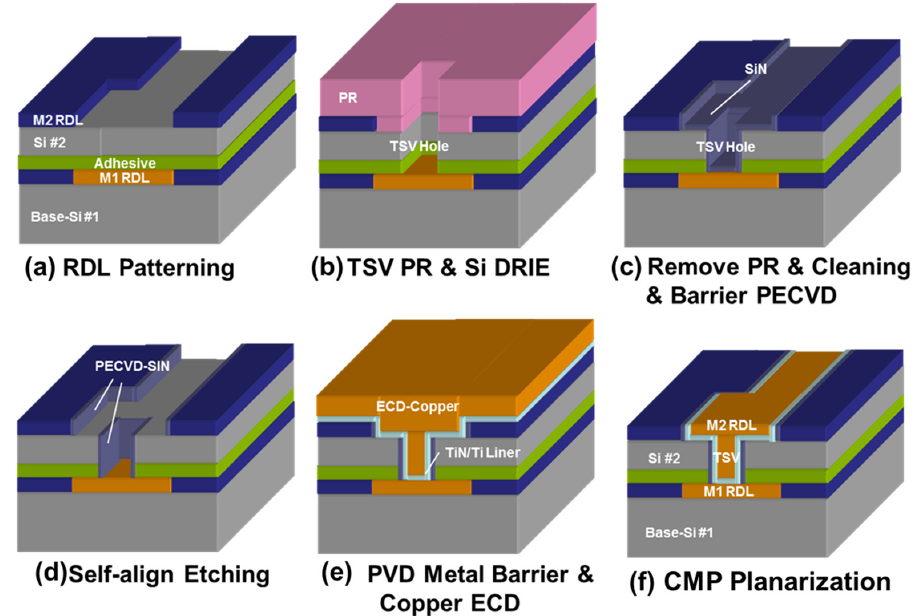
Figure 7. RDL formation and TSV (Cu plug) processes. After bonding of thinned wafer to another wafer surface, ( a ). RDL patterning, ( b ). TSV etching, ( c ). barrier layer formation, ( d ). contact opening, ( e ). Cu plug formation by ECD, and ( f ). planarization by CMP is carried out.